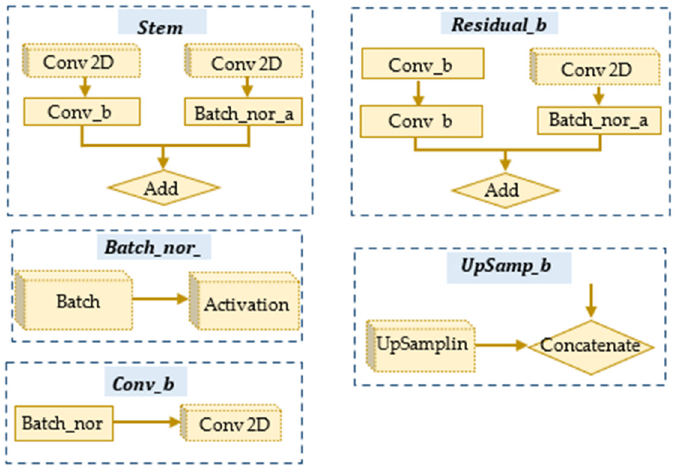
Figure 7. The main blocks of the Res-U-Net: Stem, Resudual_b, Batch_nor_a, UpSamp_b and Conv_b.